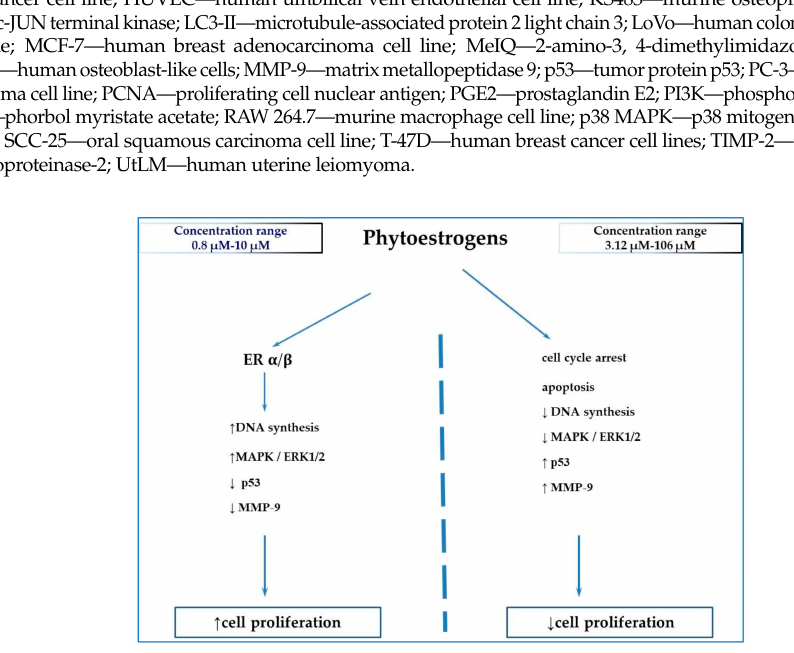
Figure 1. Suggested mechanisms of biphasic concentration-dependent e ff ects of phytoestrogens (on the basis of references cited in the review). ↑ = increase, ↓ = decrease; ER—estrogen receptor; ERK—extracellular signal-regulated kinase protein-serine / threonine kinase; MAPK—mitogen-activated protein kinase; MMP-9—matrix metallopeptidase 9; p53—tumor protein